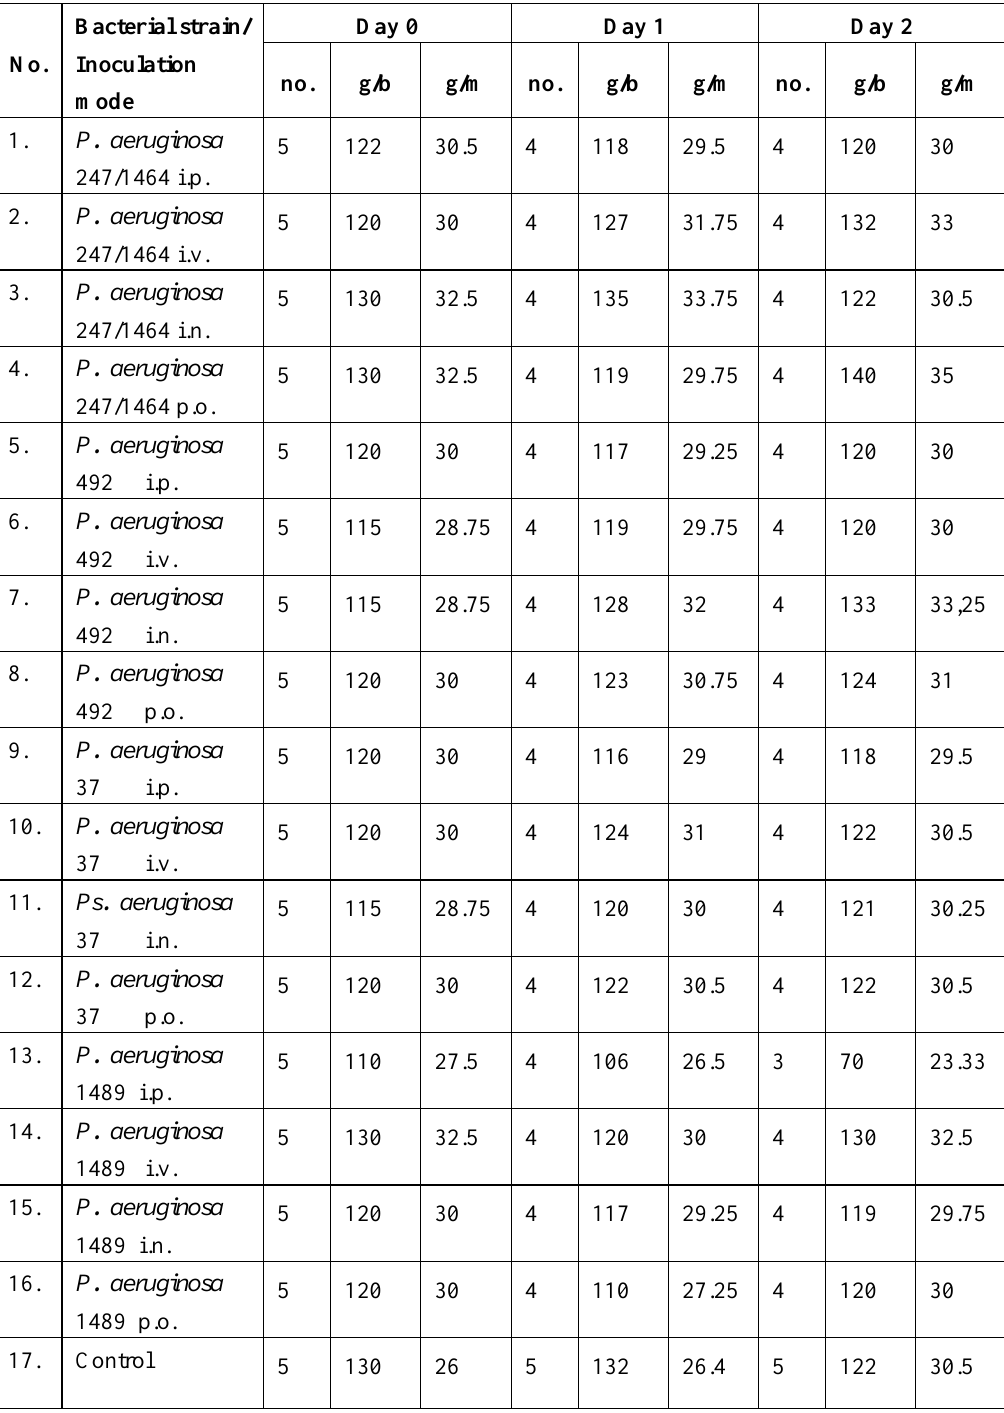
Table 2. Mortality and body weight dynamics in animals infected with PLA treated P. aeruginosa